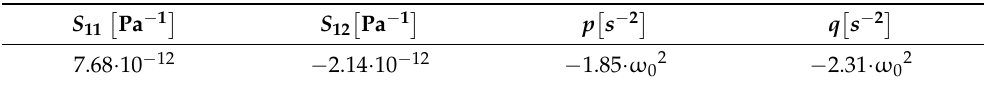
Table 2. Elastic compliance constants and phonon deformation potential values for silicon [3,9,11,25]. (cid:2) S 11 Pa − 1